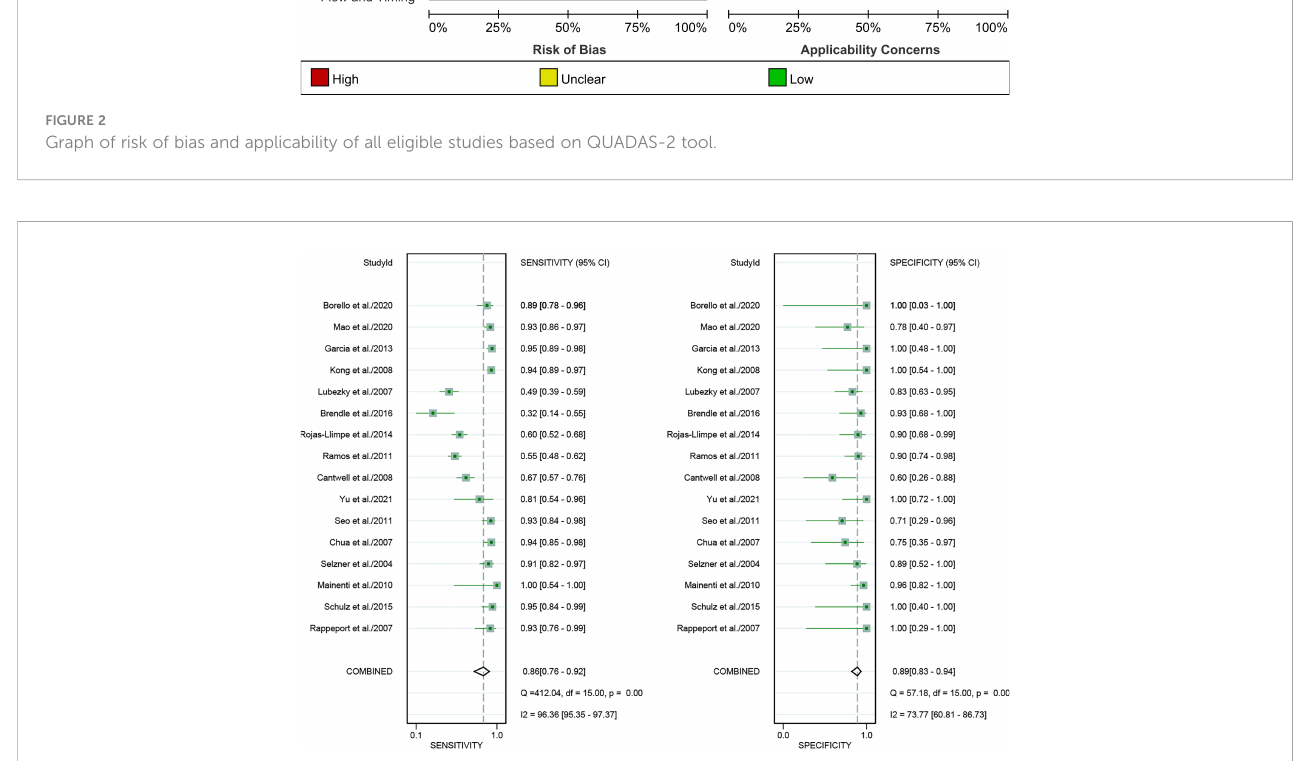
FIGURE 3 Forest plots of the combined [18F]FDG PET/CT sensitivity and speci fi city for colorectal liver metastasis. Squares denoted the sensitivity and speci fi city in each study, while horizontal bars indicated the 95% con fi dence interval.